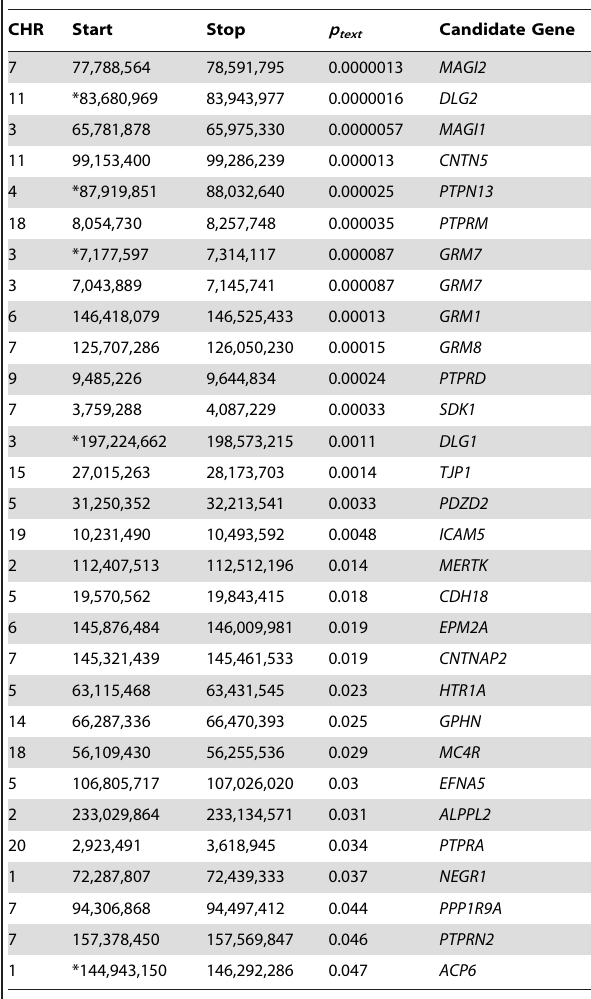
Table 3. Rare or de novo schizophrenia case